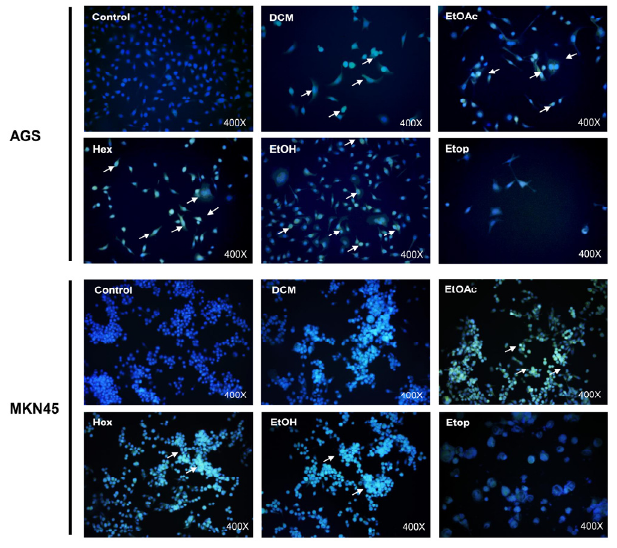
Figure 4. L. rivularis flower extracts induce senescence in gastric cancer cells. AGS and MKN-45 cells were treated with L. rivularis flower extracts (DCM 5 µ g/mL, EtOAc 5 µ g/mL, Hex 10 µ g/mL, or EtOH 15 µ g/mL) or Etoposide 25 µ M for 72 h. The cells were then incubated with CellEvent Senescence Green β -gal substrate at pH 5 for 2 h at 37 ◦ C, washed with PBS, and mounted with Fluoromount + DAPI 0.5 µ M. White arrows indicate cells with a positive green signal in representa- tive